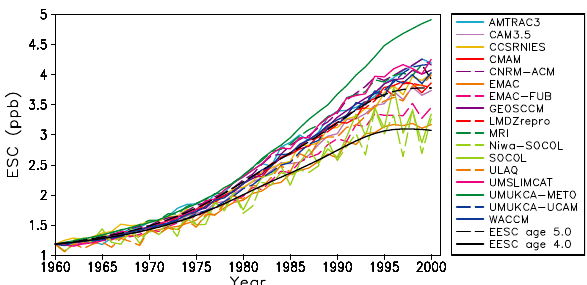
Figure 1. Evolution of Antarctic SON average ESC (in ppb) in the CCMs between 1960 and 2000, adjusted to a common baseline of 1960. Black lines show EESC (in ppb), provided by Newman et al. (2007) for mean transit times of 4 (solid) or 5 (dashed)